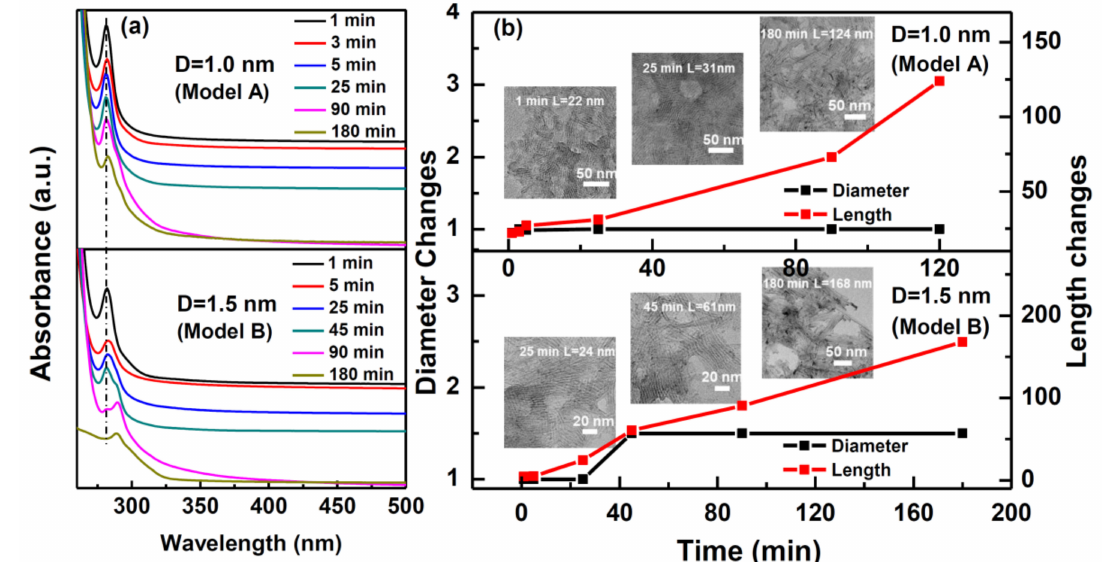
Figure 3. ( a ) Temporal evolution of absorption spectra recording the growth process of the ZnS ultrathin semiconductor nanowires (USNWs) with a diameter of 1.0 nm (model A, left top) and 1.5 nm (model B, left bottom), ( b ) The variation of the length and the diameter of the as-prepared ZnS USNWs with a diameter of 1.0 nm (model A, right top) and 1.5 nm (model B, right bottom) as a function of growth time. The insets in ( b ) are the TEM images of the ZnS nanowires formed at different reaction